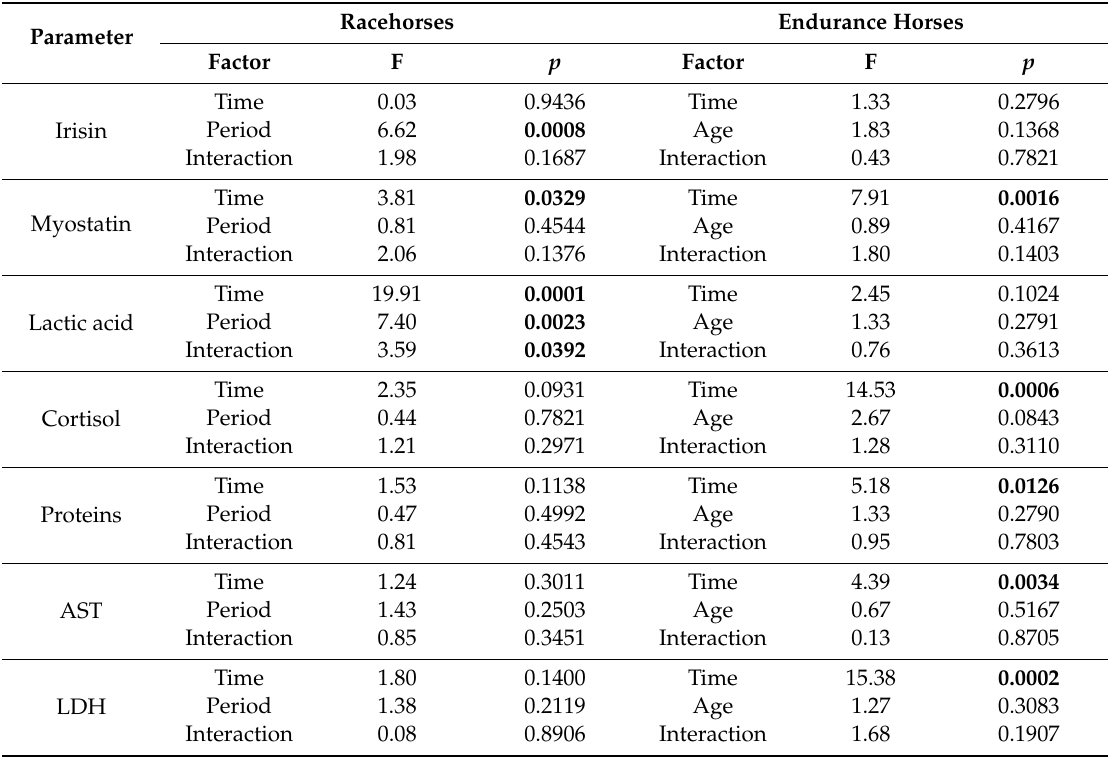
Table 2. Results of variance analysis.